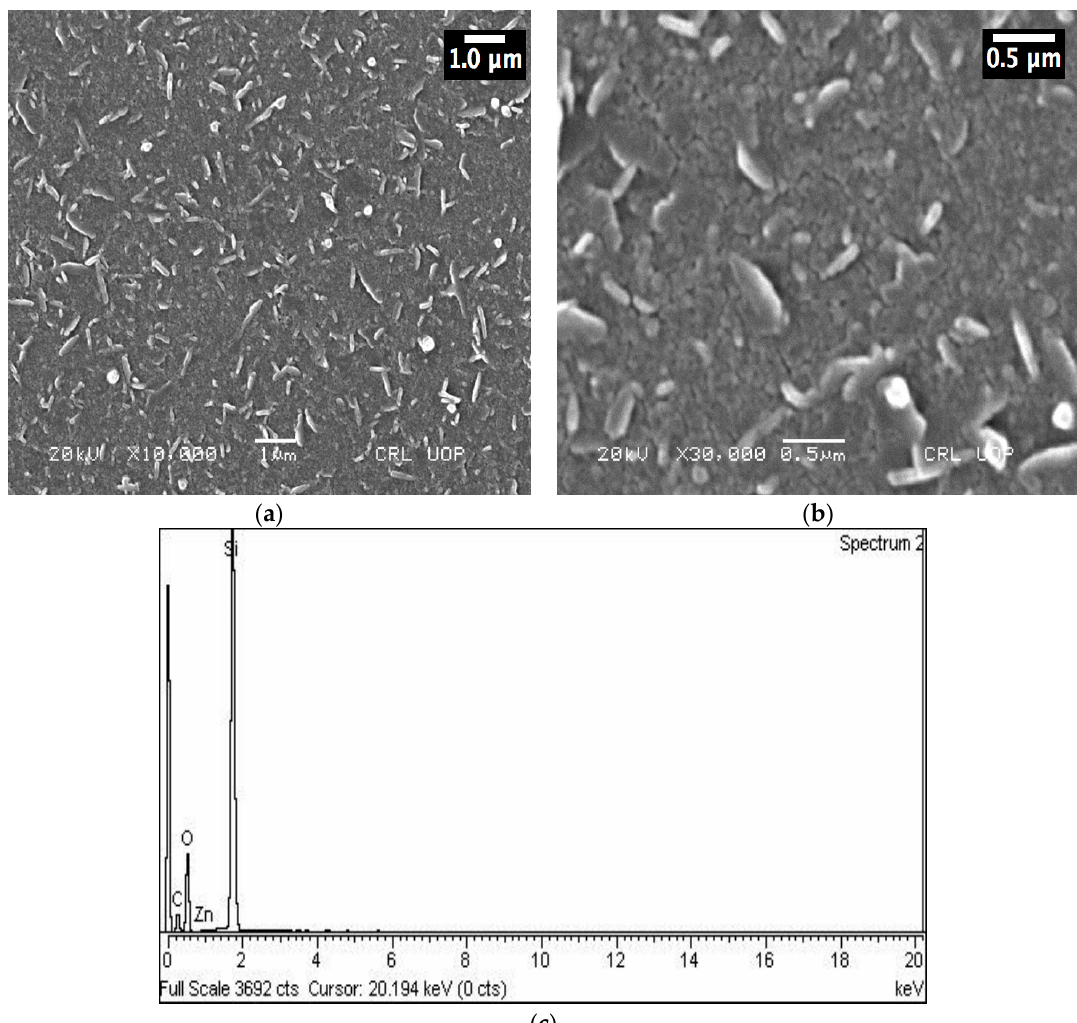
Figure 2. SEM micrographs of ZnPc thin films at ( a ) low, ( b ) high resolutions. ( c ) EDS of ZnPc thin film. Table 1. EDS details of ZnPc.